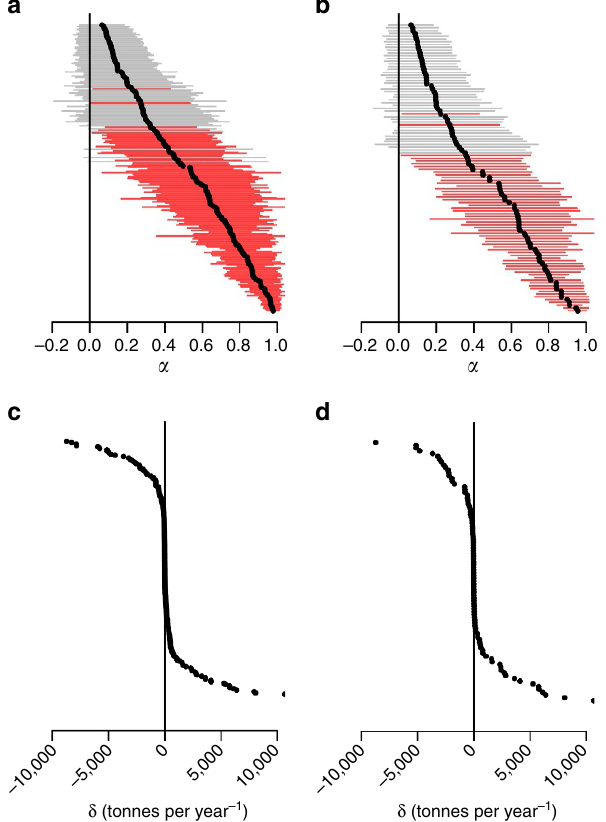
Figure 1 | Meta-analysis of static productivity residuals across fish stocks. Shown are the estimated autoregressive parameter a ( a , b ) and stochastic trend parameter d ( c , d ) fitted to the biomass residuals of the static Graham–Schaefer model for all 276 stocks ( a , c ) and those stocks depleted below B MSY ( b , d ). The horizontal lines in a , b represent the 95% credible intervals, with red lines representing cases that do not overlap zero. Plotting of credible intervals is suppressed for c , d for presentation